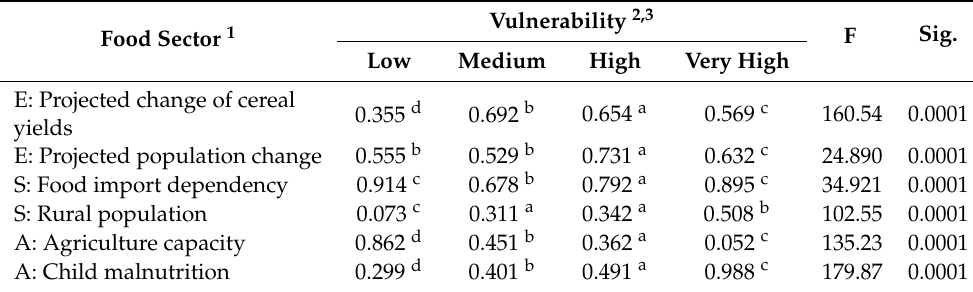
Table 3. Climate change vulnerability classes by food sector vulnerability